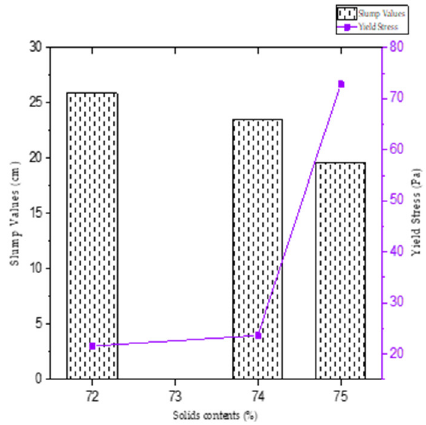
Figure 6. Relationship between yield stress and slump values for different CTB at Cw 72 wt. %, 74 wt. % and 75 wt. % and binder of 1 wt. %.